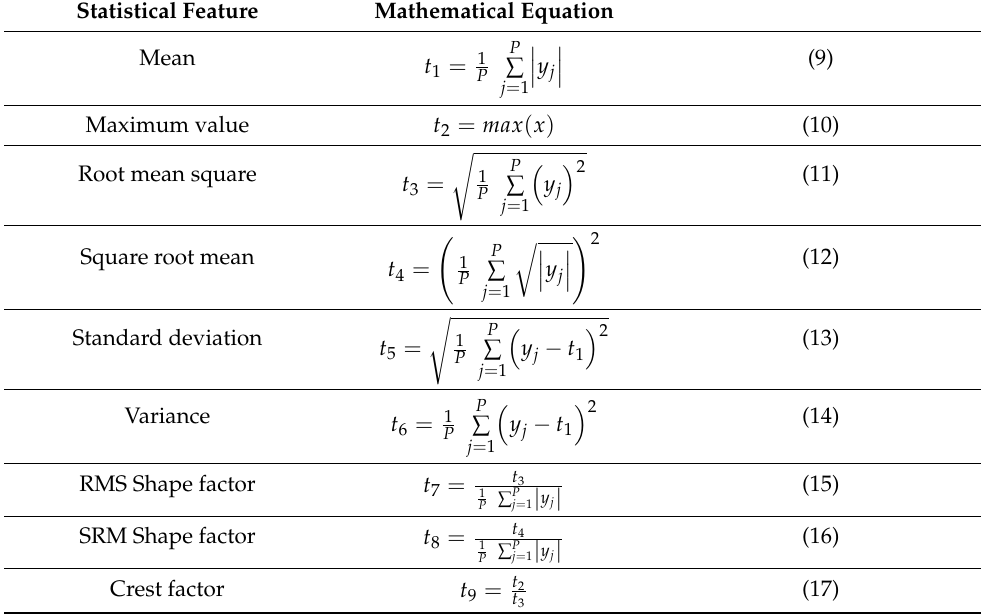
Table 1. Proposed set of statistical time domain features estimated during the signal processing in the TD analysis, where each y(j) value belongs to each sample point of the processed signal for j = 1, 2, 3 . . . P , with a total number P